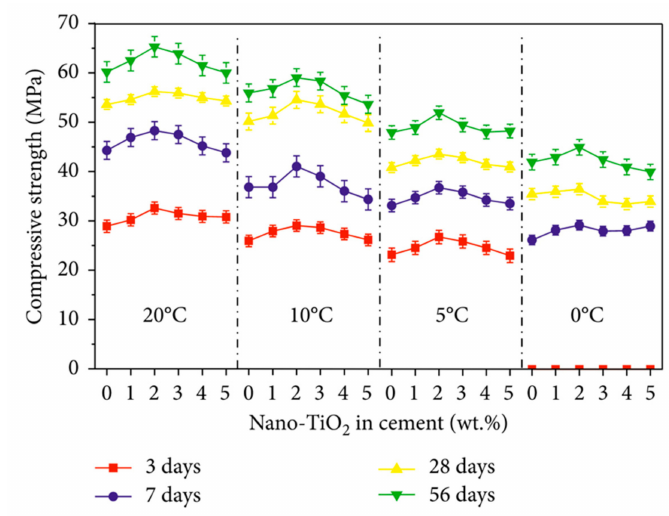
Figure 12. Compressive strength of cement mortar samples incorporating di ff erent nano-TiO 2 dosages. Reprinted with permission from [97]. Copyright © 2018, Hindawi.